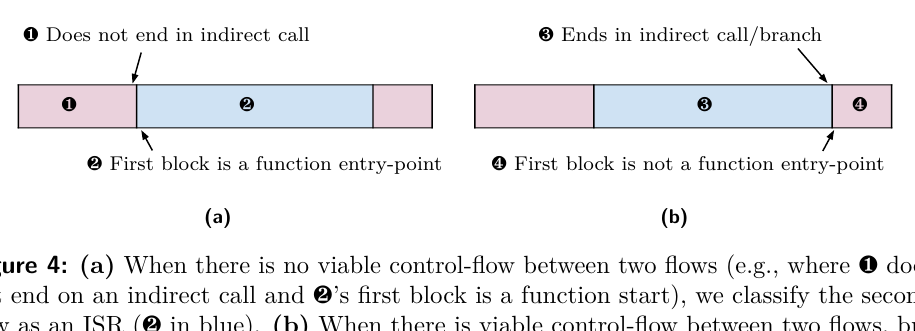
Figure 4: (a) When there is no viable control-flow between two flows (e.g., where (cid:182) does not end on an indirect call and (cid:183) ’s first block is a function start), we classify the second flow as an ISR ( (cid:183) in blue). (b) When there is viable control-flow between two flows, but it is not regular (e.g., where (cid:184) ’s last block ends on an indirect call and (cid:185) ’s first block is not a function start), we classify the first as task-switching logic ( (cid:184) in blue).